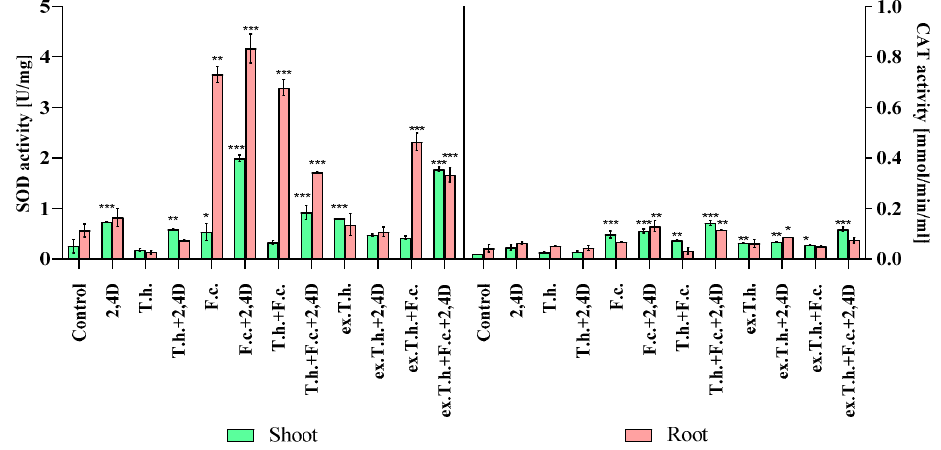
Figure 6. The oxidoreduction enzyme activity levels of the seedlings measured after 7 days of cultivation (T.h.— T. harzianum -inoculated wheat seeds; F.c.— F. culmorum -inoculated wheat seeds; ex.T.h.— T. harzianum extracellular metabolite-treated wheat seeds). Data represent means ± SE; the significance of the variance study with Tukey’s post hoc test = * p ≤ 0.05, ** p ≤ 0.01, *** p ≤ 0.001. The subcolumn statistic comparison is attached in supplementary material as Table S6.